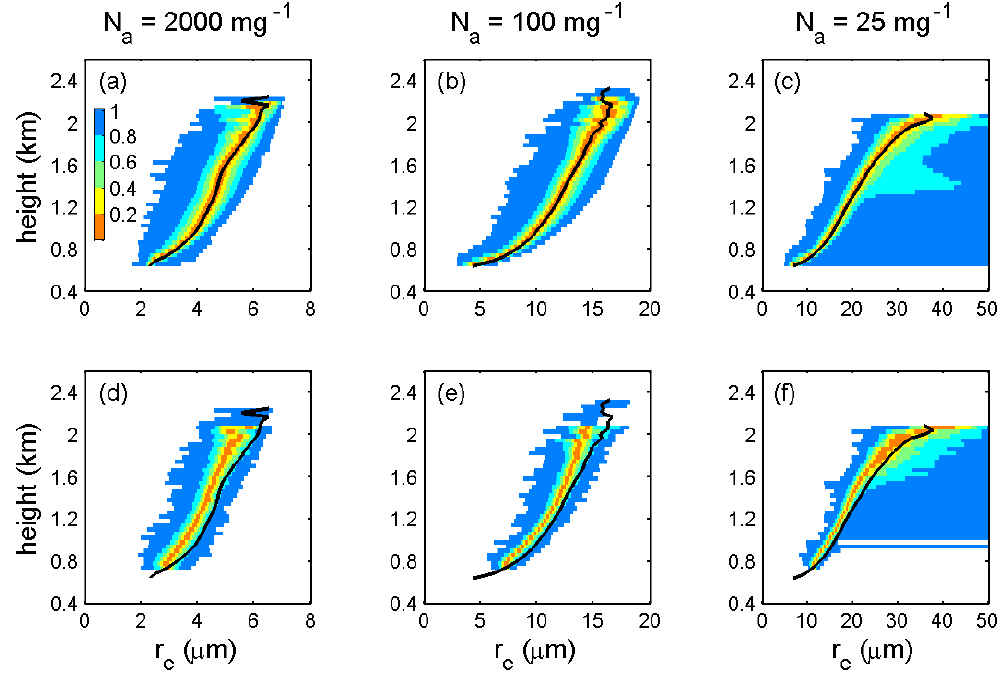
Fig. 1. r e profiles of cloud population in the last 4h of simulation in the polluted ( N a =2000mg − 1 ) , intermediate ( N a =100mg − 1 ) , and clean ( N a =25mg − 1 ) cases. (a, b, c) r e profiles from all cloud samples. (d, e, f) Constructed r e profiles using cloud-top r e . Different colors represent different percentiles. (Orange: 40–60 percentiles; yellow: 30–40, 60–70 percentiles; green: 20–30, 70–80 percentiles; cyan: 10–20, 80–90 percentiles; blue: 0–10, 90–100 percentiles.) Notice that data points are few near cloud top so that only blue is used to represent 0-100 percentiles. The drizzle mode drops (larger than 50 microns) in clouds and below cloud base are not shown in the clean case for clarity. The 50th percentile of the r e from all cloud samples in each case are shown for reference (black